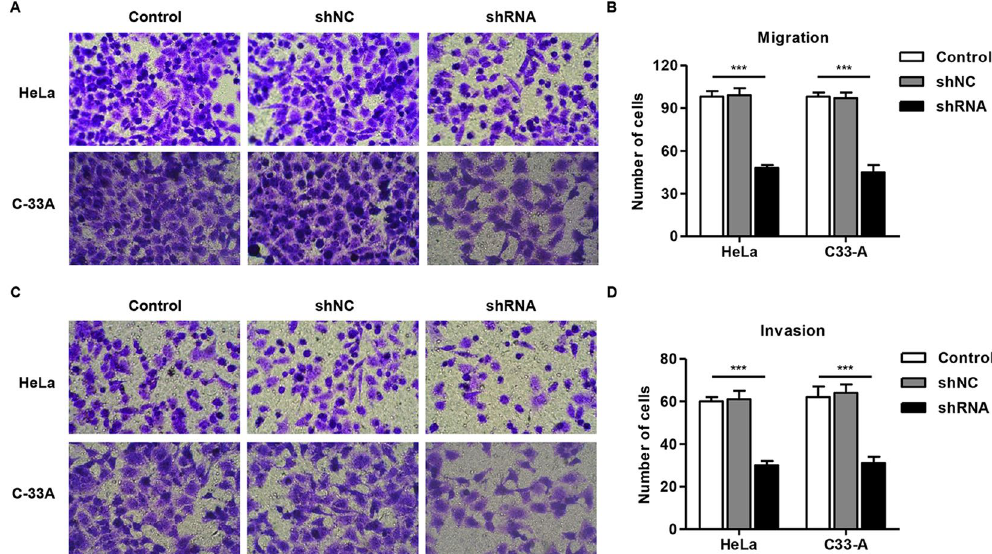
Figure 4. Effect of CKAP2 on cervical carcinoma cell migration and invasion. ( A , B ) The migration of HeLa and C-33A cells was performed by Transwell assay. ( C , D ) The invasion of HeLa and C-33A cells was performed by Transwell Matrigel assay. *** P <